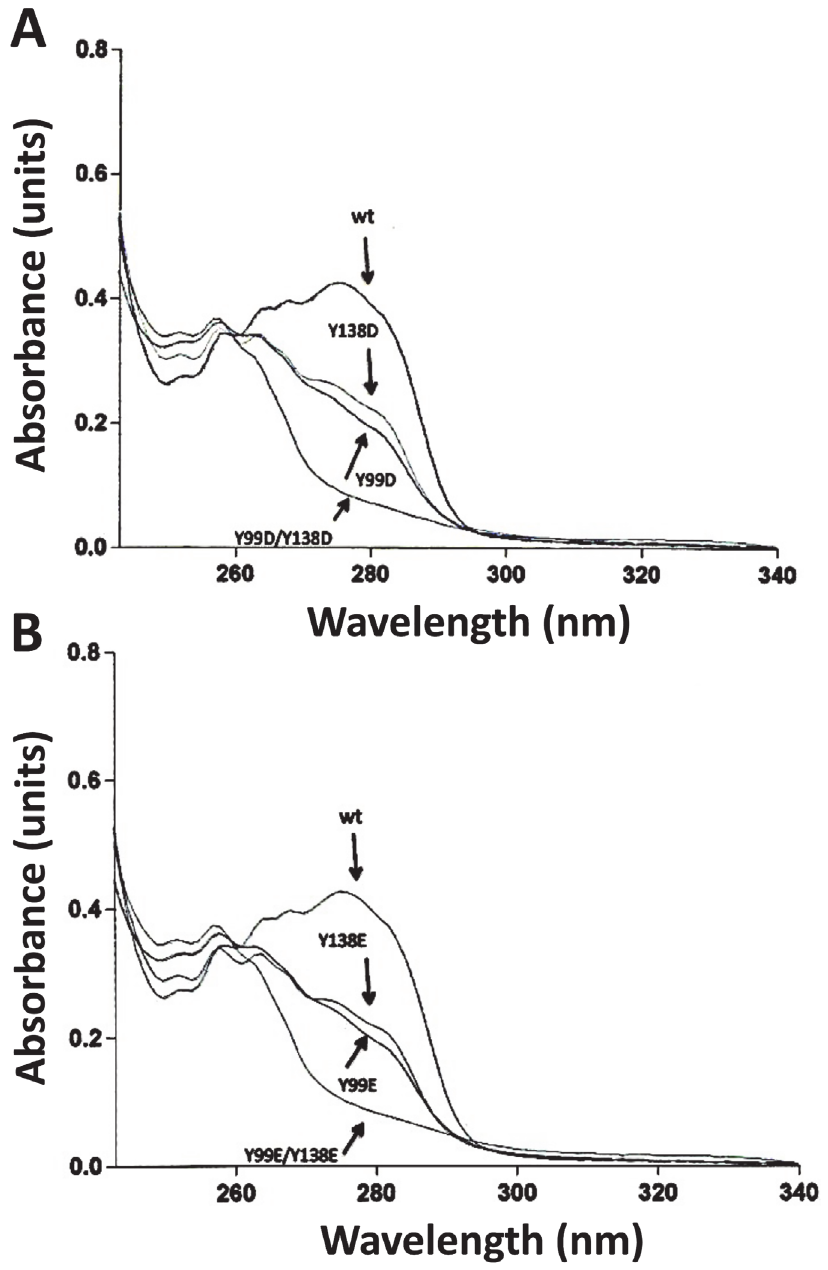
Fig 2. Absorption spectra of the different CaM species. The plots show UV-light absorption spectra of recombinant wild type ( wt ) and the indicated Y/D ( panel A ) and Y/E ( panel B ) CaM mutants (2 mg/ml) purified as described in Materials and Methods and dialyzed against 20 mM Tris-HCl (pH